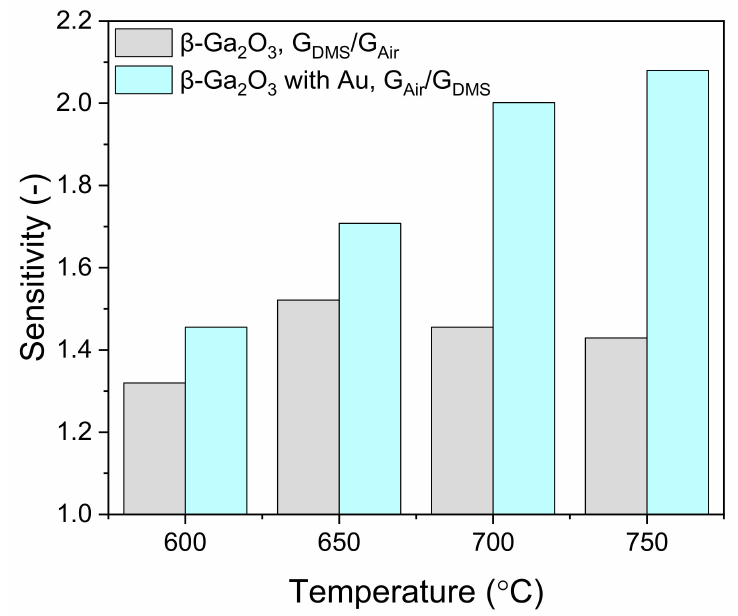
Figure 14. Sensitivity to 16 ppm of dimethyl sulfide of the unmodified and the modified β -Ga 2 O 3 layer. The response of the β -Ga 2 O 3 layer modified with Au nanoparticles is inversed; therefore, to keep the sensitivity greater than 1, the formula is also inversed (i.e., S = G Air / G DMS